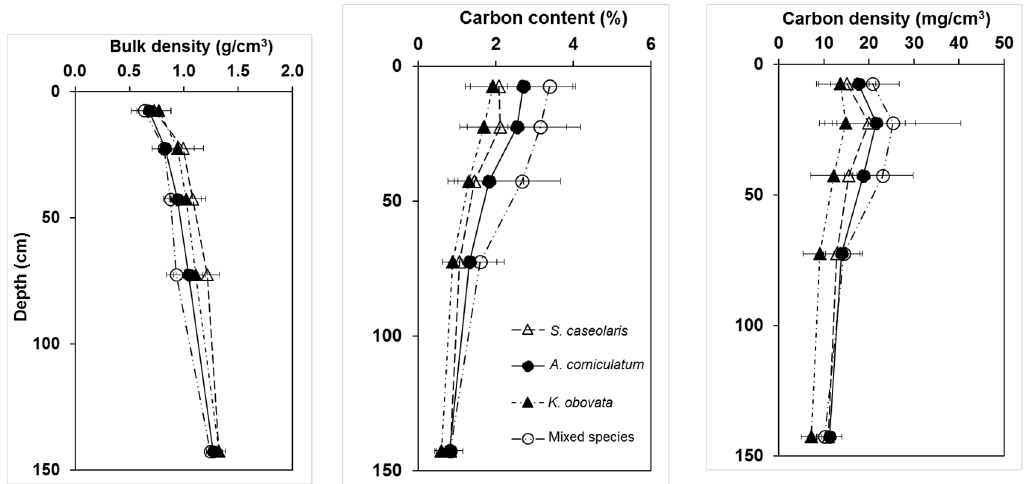
Figure 3. Soil properties according to mangrove species in northern Vietnam.